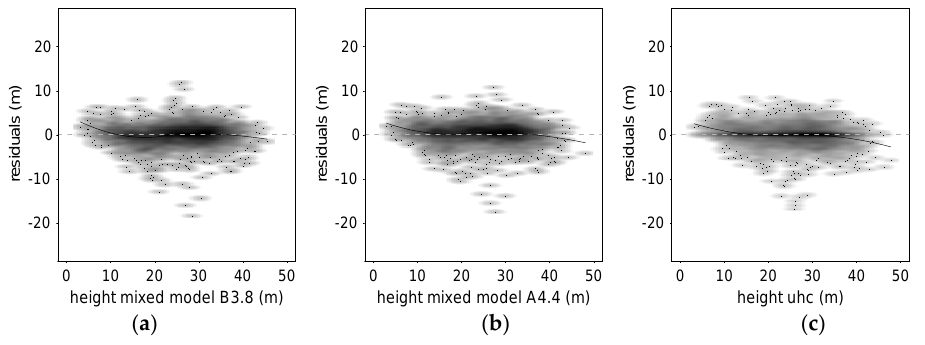
Figure 3. Residuals against predicted heights. Smoothed densities of the corresponding scatterplots derived through two-dimensional kernel density estimates. The light-gray dashed line is zero-reference; the black solid line is polynomial regression fit. ( a ) Model B3, Calibration Strategy 8; ( b ) Model A4, Calibration Strategy 4; and ( c ) uhc model.